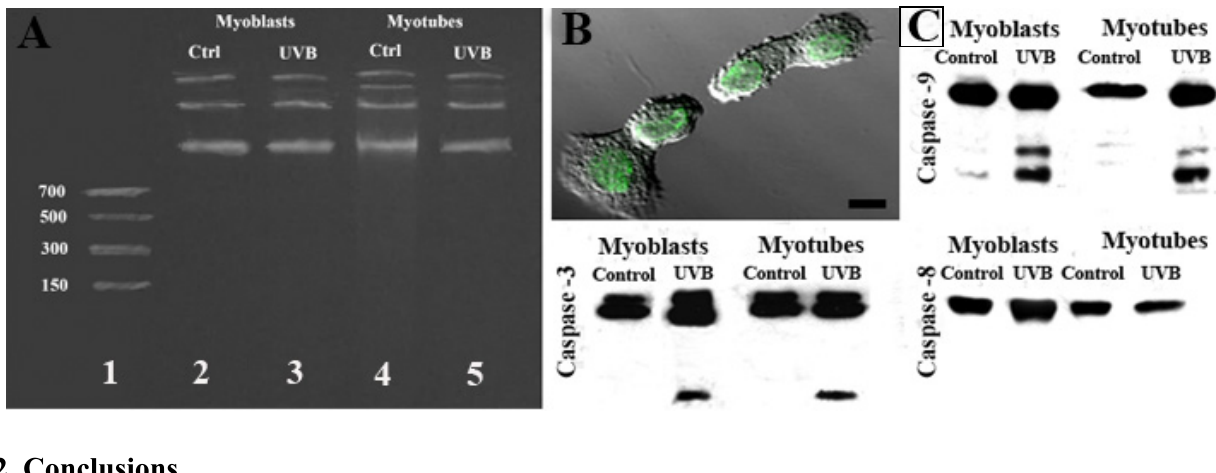
Figure 6. DNA cleavage ( A ) is absent in control myoblasts (lane 2) and myotubes (lane 4) and in UVB-treated myoblasts (lane 3) and myotubes (lane 5). Nevertheless, TUNEL positive nuclei were observed in treated myoblasts at confocal microscopy ( B ). Caspase-9 and -3 activation and caspase-8 absence were demonstrated by Western blotting, both in myoblasts and myotubes ( C ). Scale bar: ( B ) 20